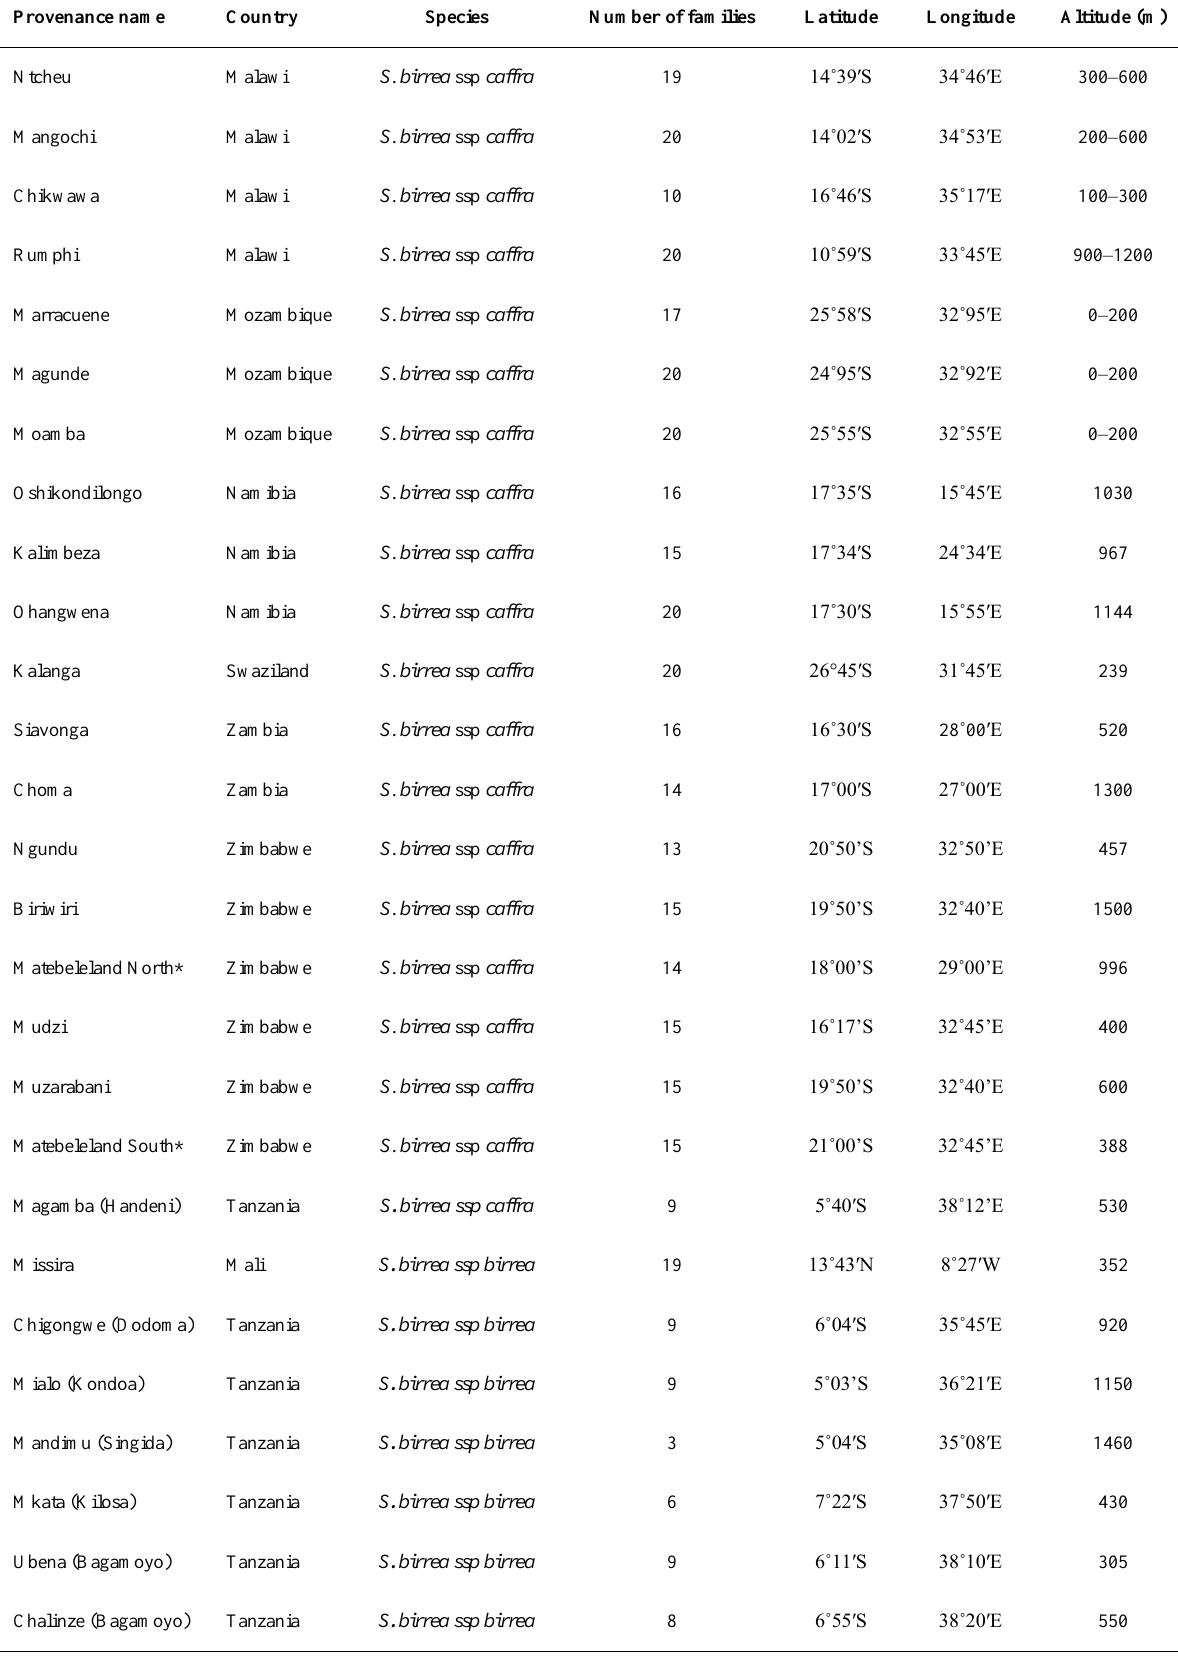
Table 1. Geographic details of the Marula germplasm tested in